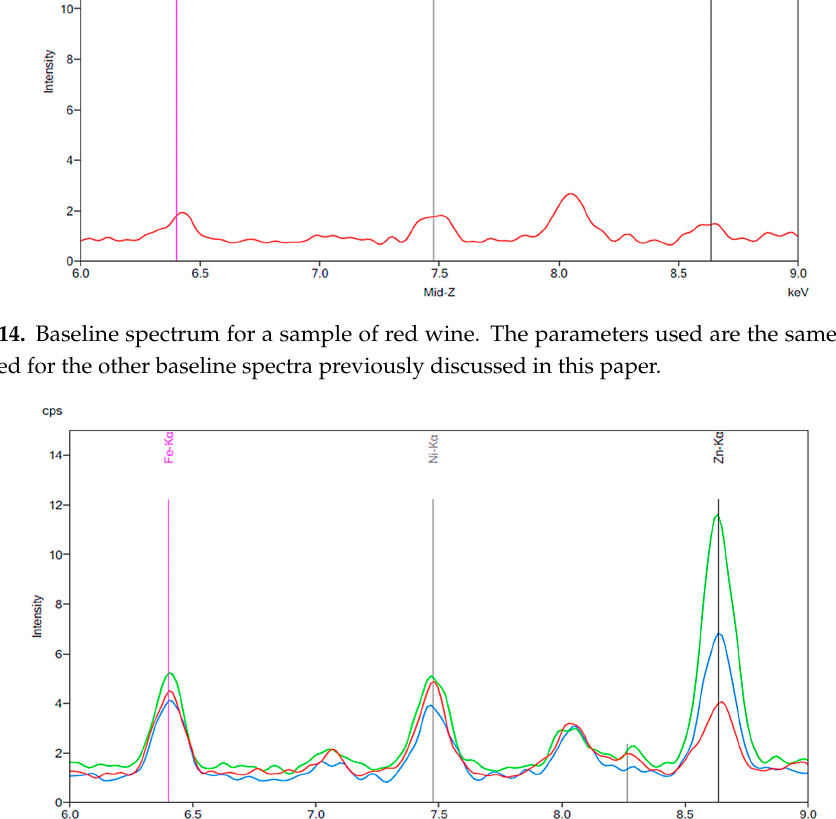
Figure 15. The results of the brushing experiment for artificial teeth exposed to chlorhexidine. The red peaks indicate new artificial teeth. The green peaks represent the artificial teeth following 24 h of exposure to chlorhexidine. The blue peaks correspond to the chlorhexidine exposed teeth following 30 s of brushing.